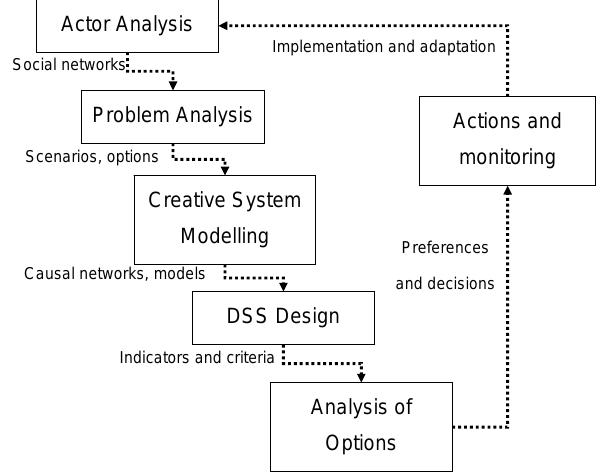
Figure 6.1: The NetSyMoD approach for participatory modelling and decision making (source: Giupponi et al., 2008).